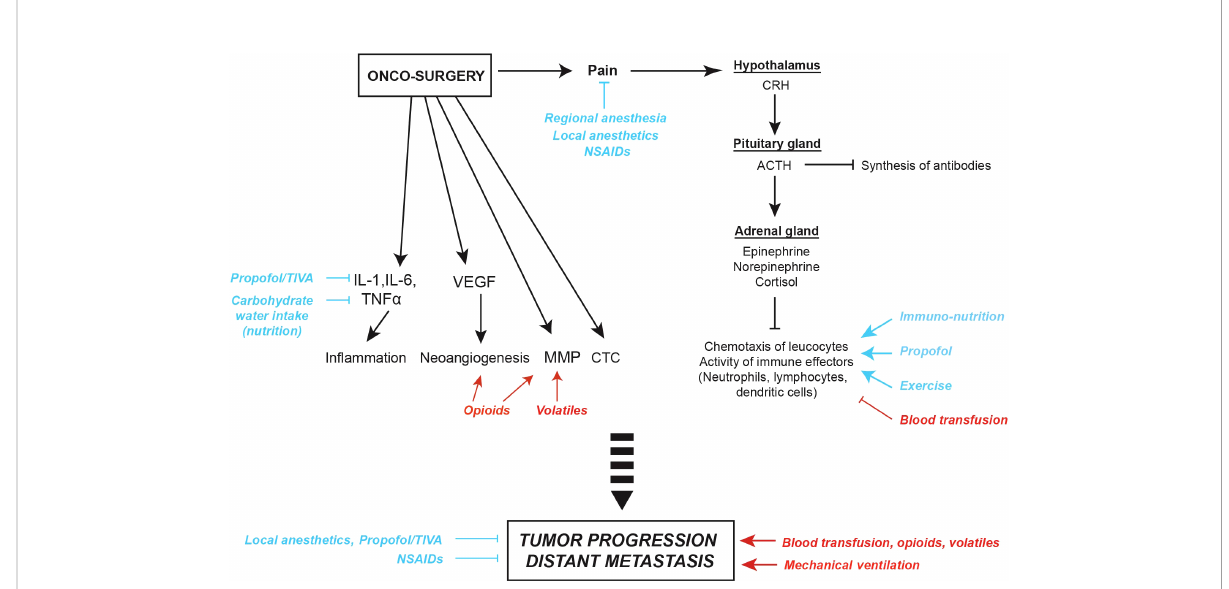
FIGURE 1 Surgical stress and potential anti- and pro-tumor effects of anesthesia, analgesia and peri-operative factors. Surgical pain can trigger corticotropic signaling, thus favoring the release of endocrine neurotransmitters such as epinephrine, norepinephrine and cortisol. Moreover, metabolic changes induced by surgical stress can impact on the chemotaxis of leucocytes and, as a consequence, induce leukopenia and suppress anticancer immune responses. Oncological procedures can also activate local and systemic in fl ammatory responses re fl ected by the release of interleukin-1 (IL-1), IL-6 and tumor necrosis factor alpha (TNF a ), trigger the synthesis of vascular endothelial growth factor (VEGF) promoting neoangiogenesis, and increase the release of matrix metalloproteinases (MMP) facilitating the dissemination of circulating tumor cells (CTC). Thus, anesthetic agents and peri- operative factors may mediate either pro- (red) or anti-tumor effects (blue). ACTH, Adreno CorticoTropic Hormone; CRH, Corticotropin-Releasing Hormone; NSAIDs, Non-Steroidal Anti-In fl ammatory Drugs; TIVA, Total IntraVenous